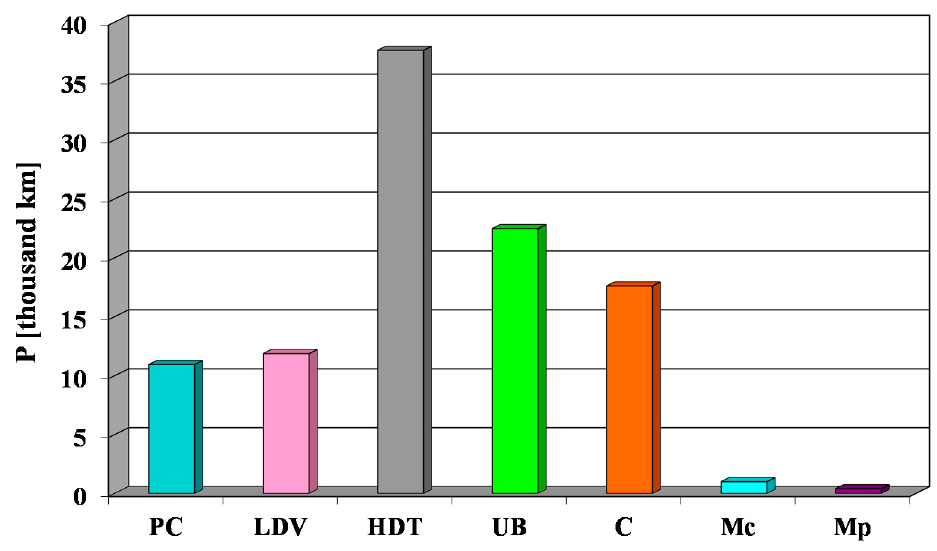
Figure 3. Annual mileage (P) of passenger cars (PC), light duty vehicles (LDV), heavy duty vehicles (HDT), urban buses (UB), coaches (C), motorcycles and quads (Mc) and mopeds (Mp).